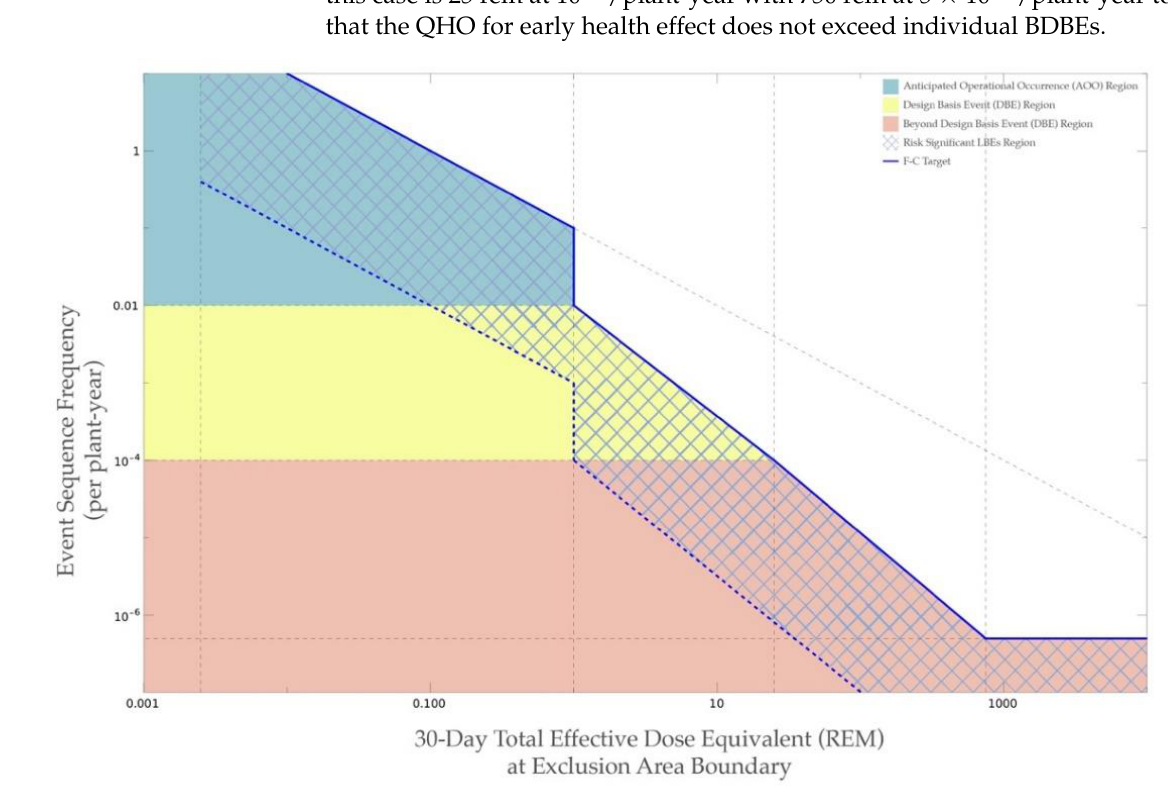
Figure 2. Frequency-Consequence Target (reproduced from [51]) .